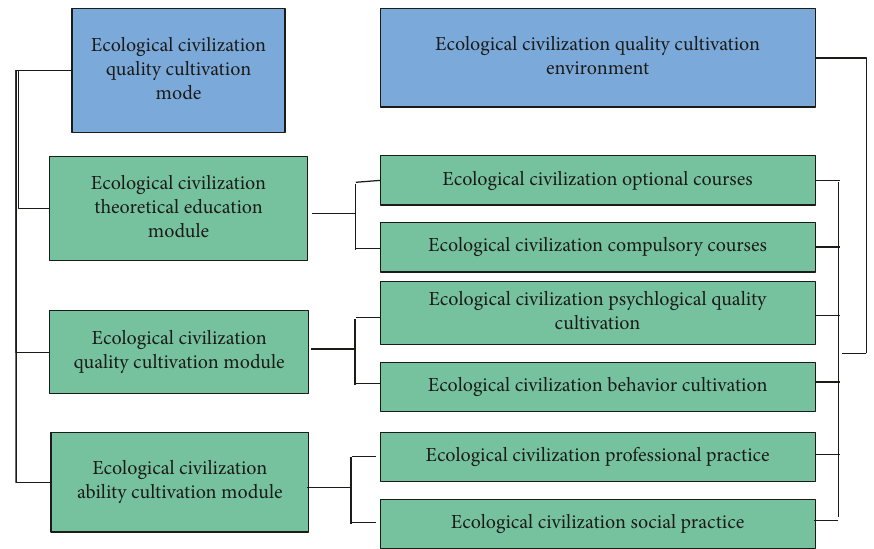
Figure 3: A new model for the cultivation of ecological civilization quality of college